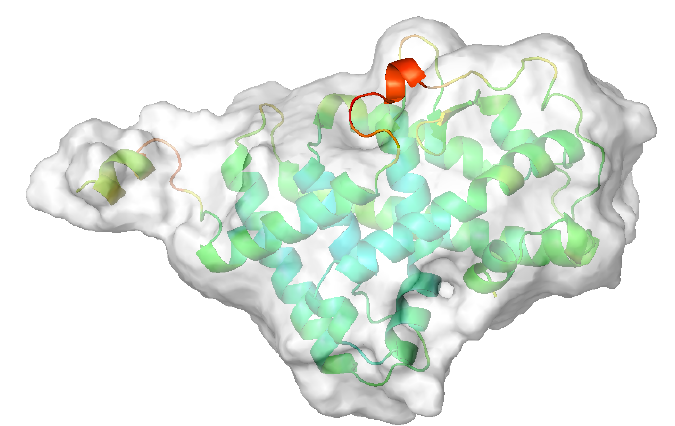
Figure 3. The reconstructed model and the calculated protein boundary of the test